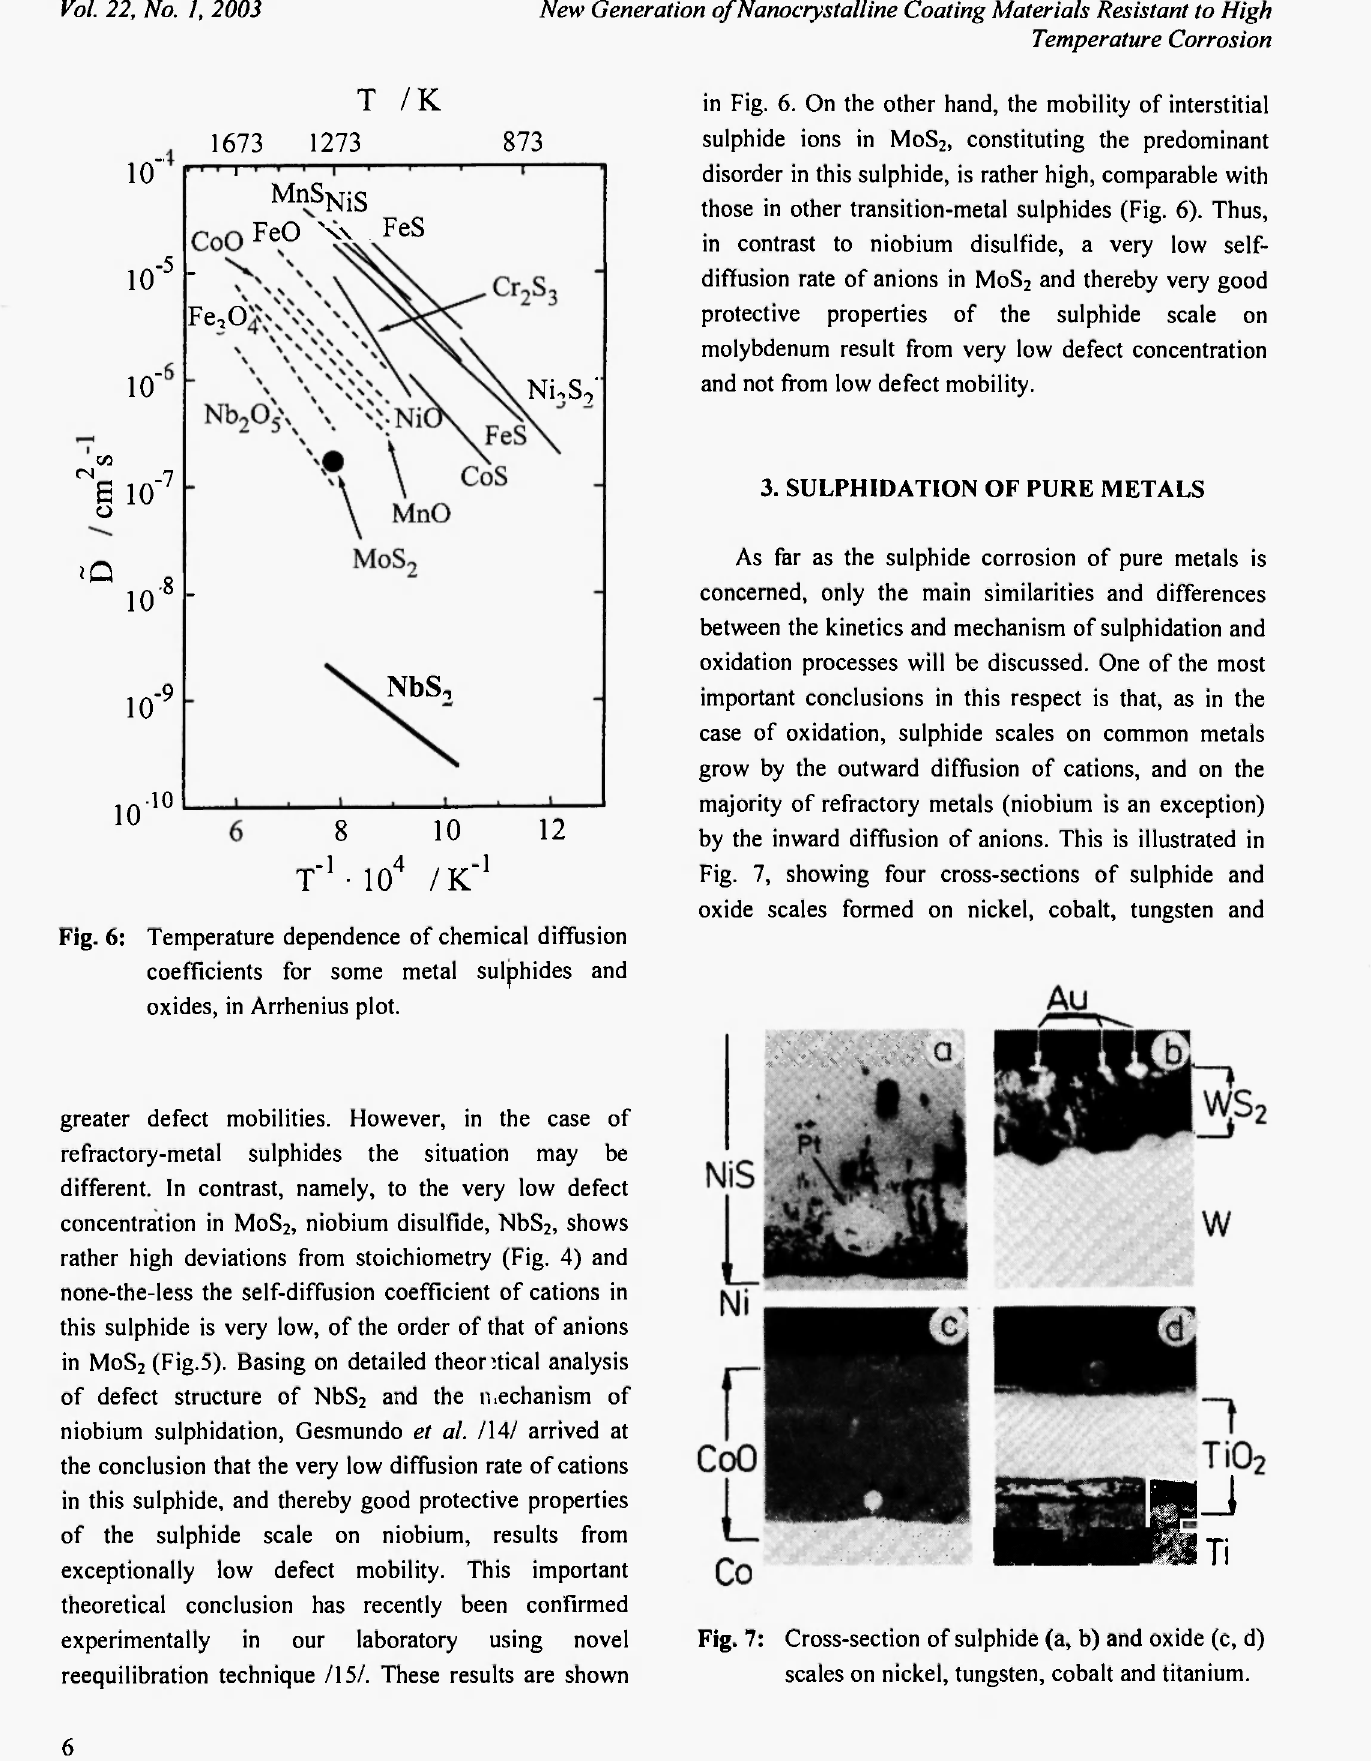
Fig. 7: Cross-section of sulphide (a, b) and oxide (c, d) scales on nickel, tungsten, cobalt and